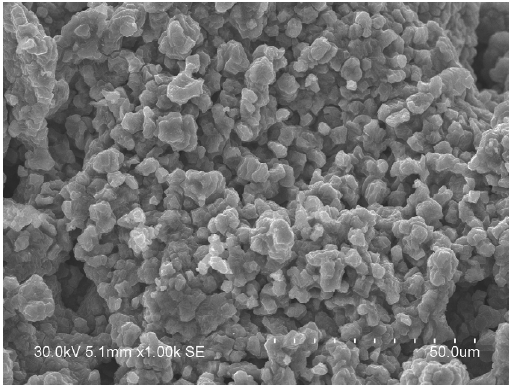
Figure 8. Micrograph of the product of SHS in the Ti + 0.3C mixture ball-milled for 10 min. Combustion in nitrogen.